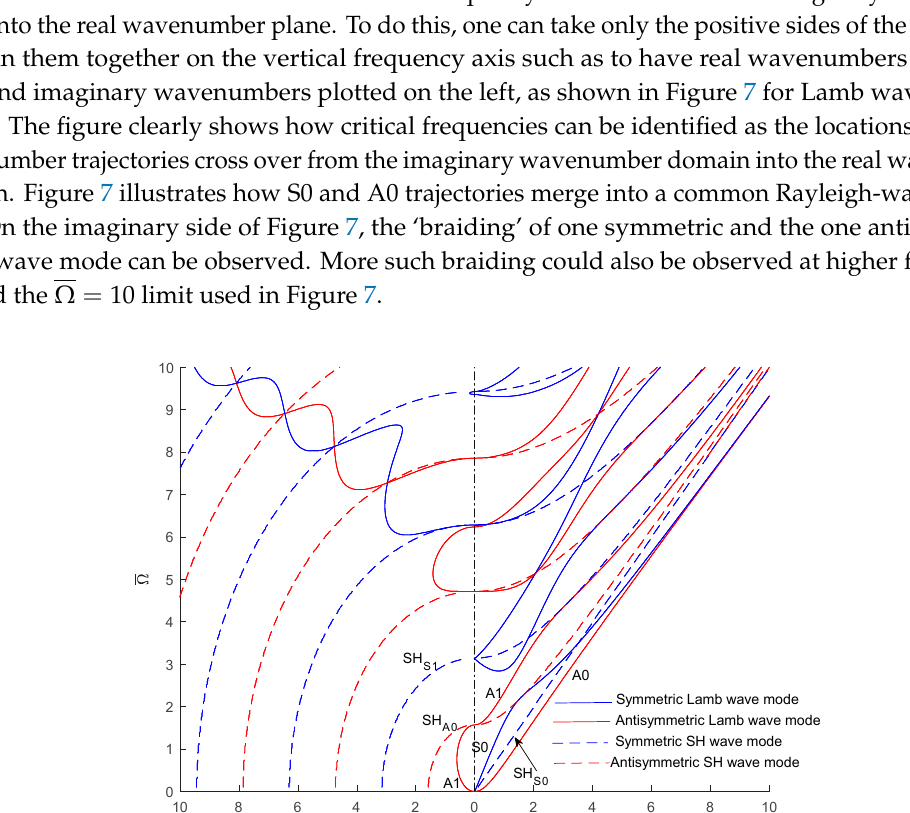
given by the analytical method: ( a ) real wavenumbers; ( b ) imaginary wavenumbers.